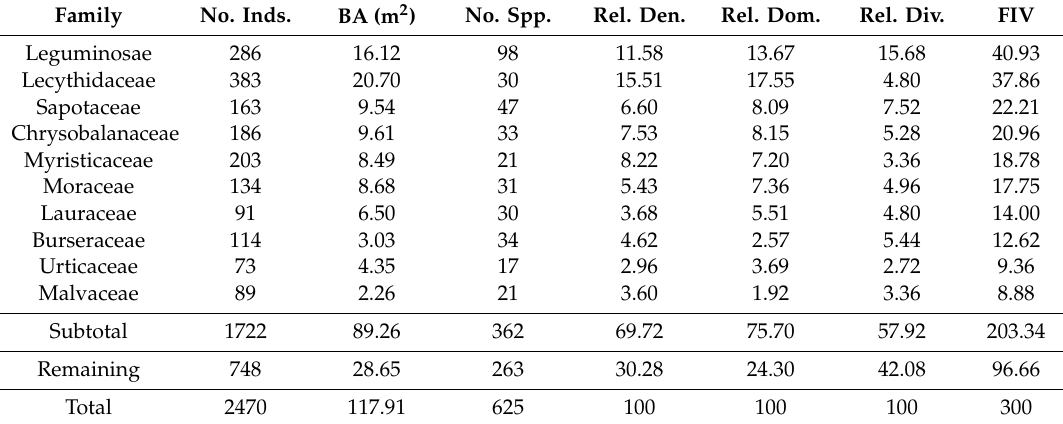
Table 3. The ten most important families in lowland terra firme, listed in descending order of family importance value (FIV). Values are based on all woody plants with species identifications. The number of individuals (No. Inds.) and the number of species within each family (No. Spp.) are given as counts. Basal area (BA) in m 2 . Relative density (Rel. Den.), relative dominance (Rel. Dom.) and relative diversity (Rel. Div.) are given as percentages, where 100 equals 100% (Supplementary Table S1).